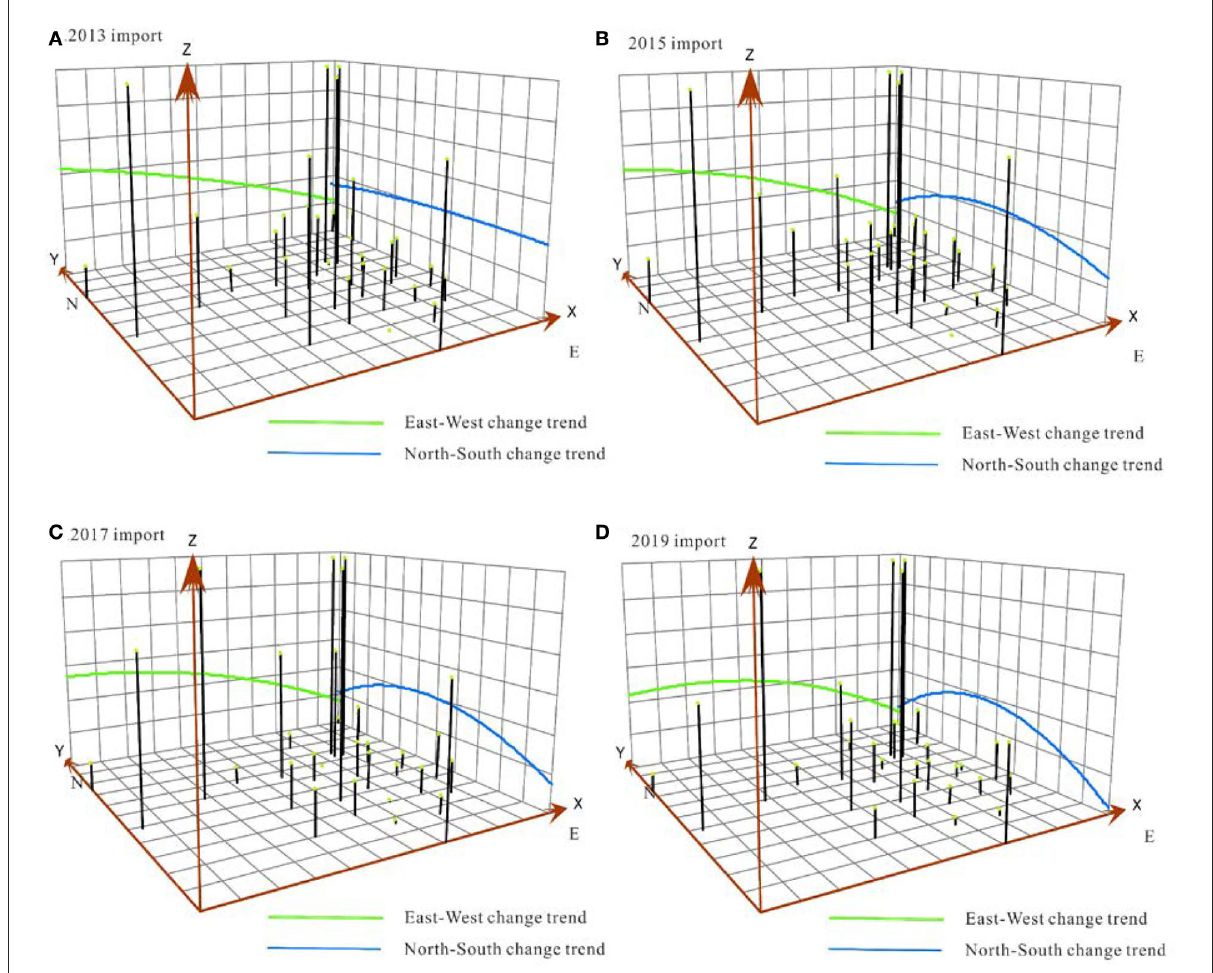
FIGURE7 Spatial change trend of the HHI of railway container freight at the provincial scale (import).